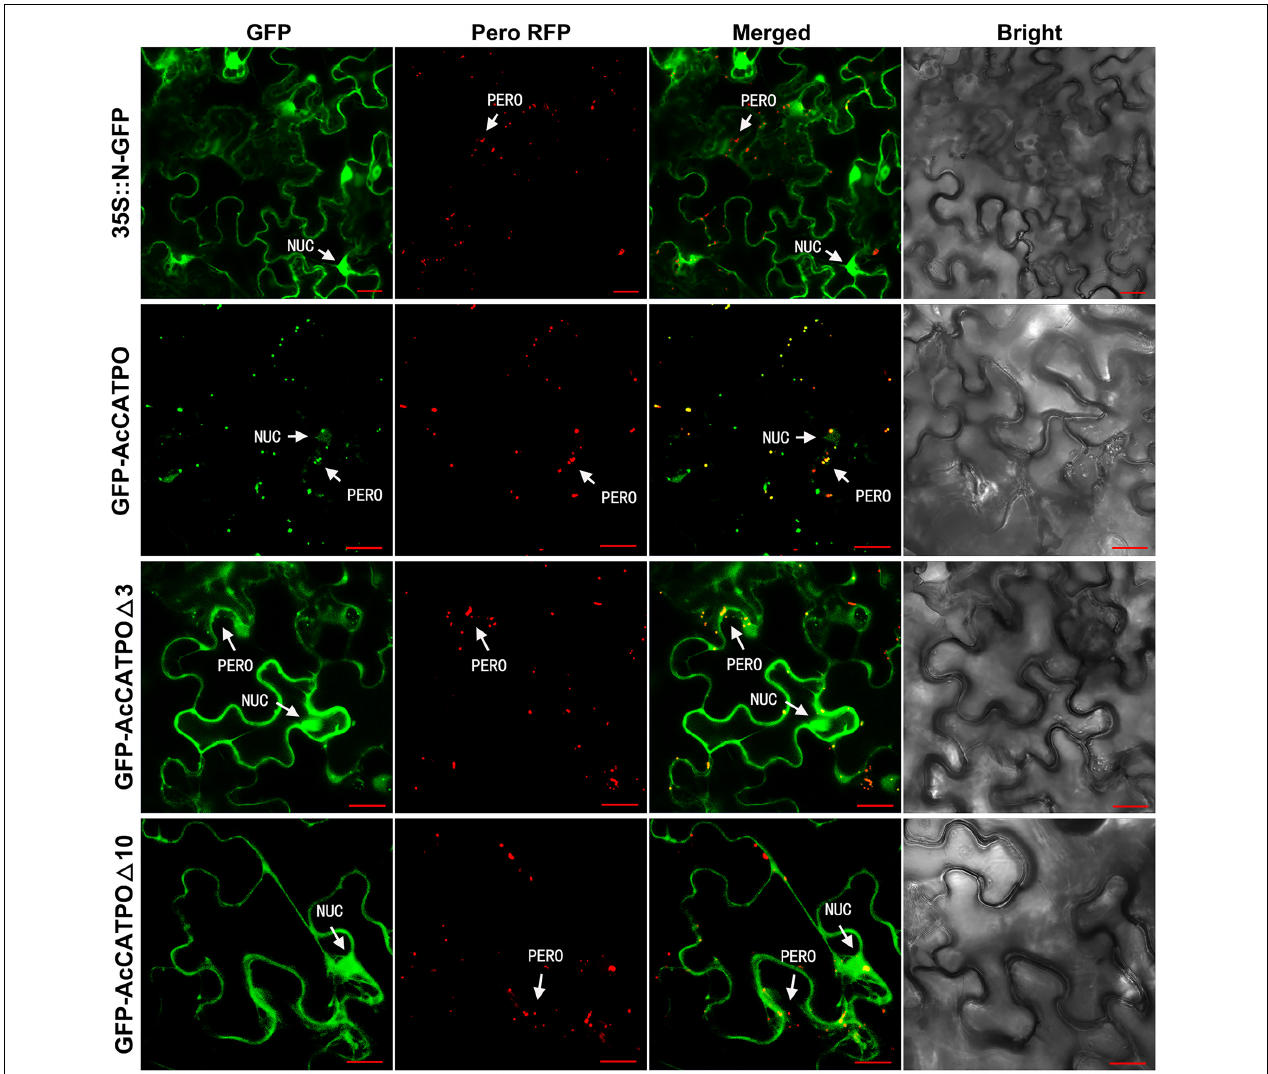
FIGURE 2 | Confocal fluorescence scanning of AcCATPO and AcCATPO (cid:49) with N-terminal GFP tag (GFP-Gene). Each GFP construct and peroxisomal RFP marker were co-transformed to tobacco ( Nicotiana benthamiana ) leaf epidermal cells by agro-infiltration, and 2 or 3 days after infiltration, the cells were subjected to Carl Zeiss 710 confocal laser scanning microscopy for fluorescence detection. NUC, nucleus; PERO, peroxisome; Pero RFP, Peroxisome-localized RFP marker; (cid:49) 3 and (cid:49) 10, C-terminal 3 or 10 amino acids deleted, respectively; GFP-AcCATPO, GFP-AcCATPO (cid:49) 3 and GFP-AcCATPO (cid:49) 10, GFP tagged at the N-terminus of the protein; Bar = 20 µ